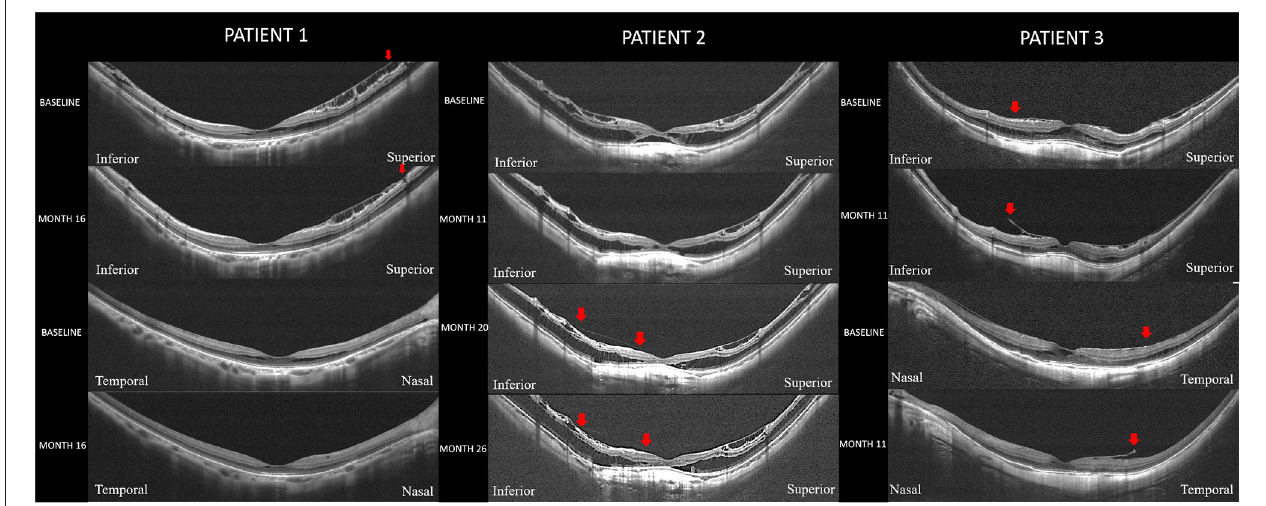
FIGURE 4 | Representative cases with spontaneous resolution of myopic traction maculopathy. Patient 1: Resolution of a macular retinoschisis in an eye with a disruption of the internal limiting membrane (ILM). Right eye with an axial length of 27.05mm in a woman (50-year-old). Optical coherence tomography (OCT) scan in both the vertical and horizontal section at baseline showed a shallow foveal retinoschisis with ILM detachment. Sixteen months later, a disruption of the detached ILM superior to the fovea is observed (red arrow) and the foveal retinoschisis is disappeared. Patient 2: Resolution of a foveal detachment in an eye with a partial posterior vitreous detachment (PVD). Right eye with an axial length of 32.86mm in a man (53-year-old). OCT scan in vertical section at baseline showed a shallow foveal detachment with retinoschisis spanning the entire macula. No signs of PVD were noted. Eleven months later, the foveal detachment has almost resolved and both the inner and outer retinoschisis has resolved. Twenty months after the initial visit, the foveal detachment has completely resolved. A residual vitreoretinal adhesion (between two red arrows) left after partial PVD can be seen. Twenty-six months of follow-up, the retinoschisis and vitreoretinal adhesion (between two red arrows) are stable. Patient 3: Resolution of a macular retinoschisis in an eye with a disruption of the epiretinal membrane (ERM). Left eye with an axial length of 31.46mm in a man (51-year-old). OCT scan in both the vertical and horizontal sections at baseline showed a shallow retinoschisis with tractional ERM. Eleven months later, disruptions are noted in the ERM (red arrow) nasal and inferior to the fovea. The foveal retinoschisis has disappeared and the extrafoveal retinoschisis has been resolved.